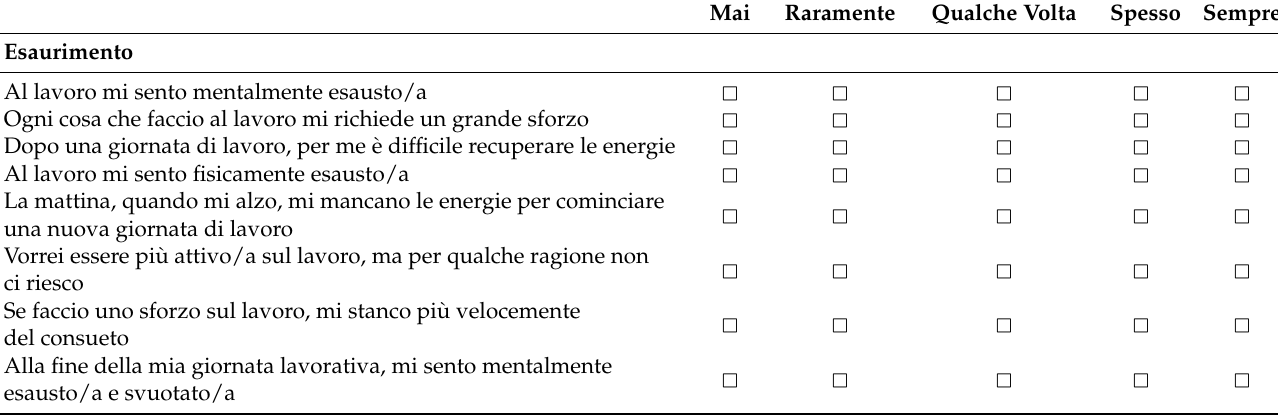
Table A1. Italian version of the Burnout Assessment Tool (BAT)—Core